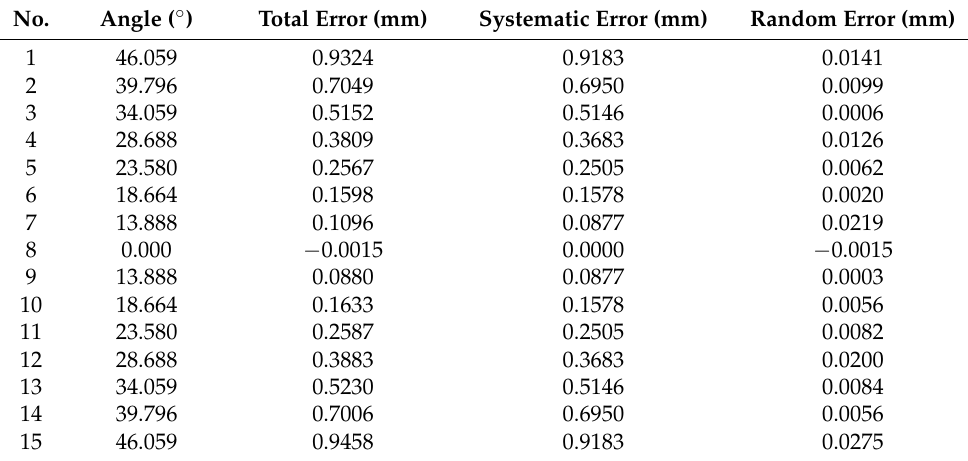
Table 5. Measurement results of the contact angle